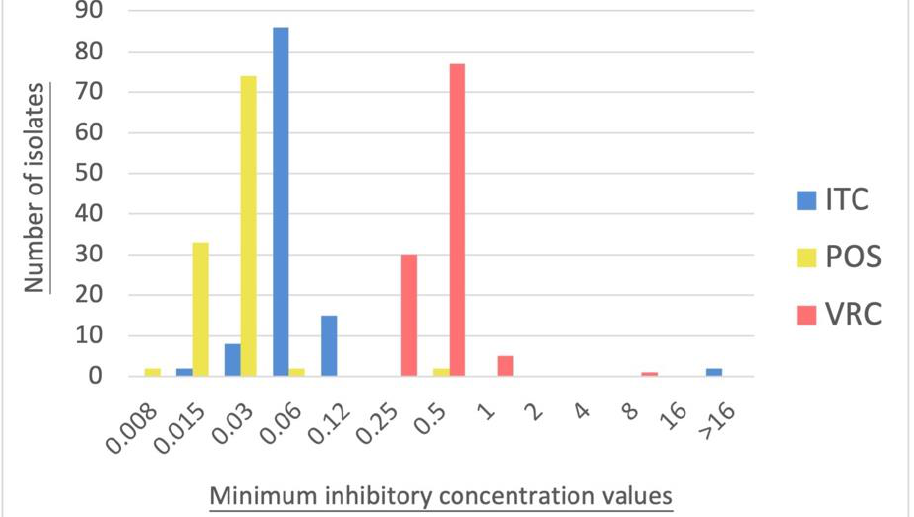
Figure 1. The distribution of the minimum inhibitory concentration values of itraconazole (ITC), posaconazole (POS), and voriconazole (VRC), as determined using the YeastOne TM method. The x -axis represents the minimum inhibitory concentration values, and the y -axis represents the number of isolates.